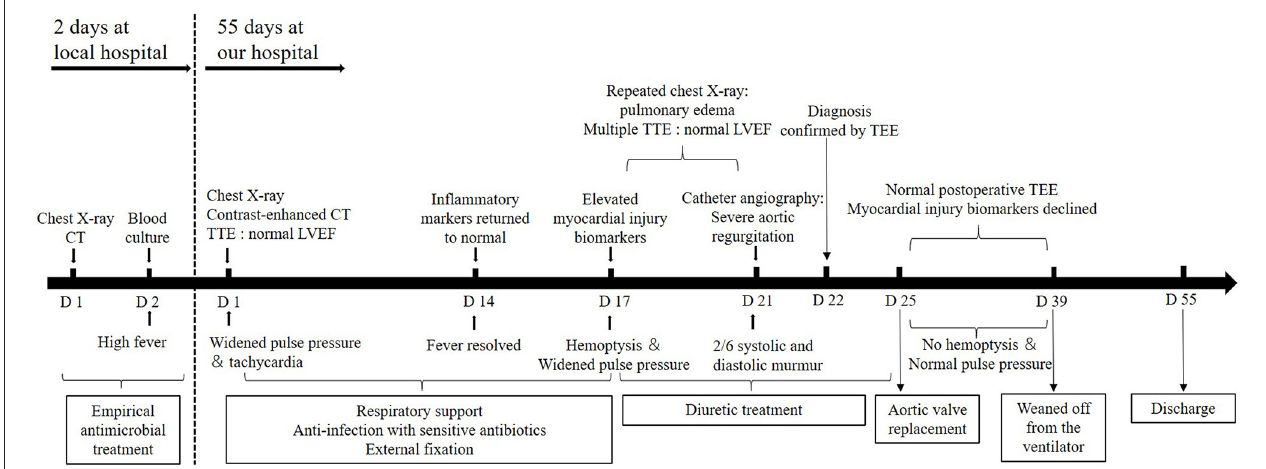
FIGURE 4 | A timeline of the patient’s diagnosis and treatment process. CT, computed tomography; TTE, transthoracic echocardiography; TEE, transesophageal echocardiography; LVEF, left ventricular ejection